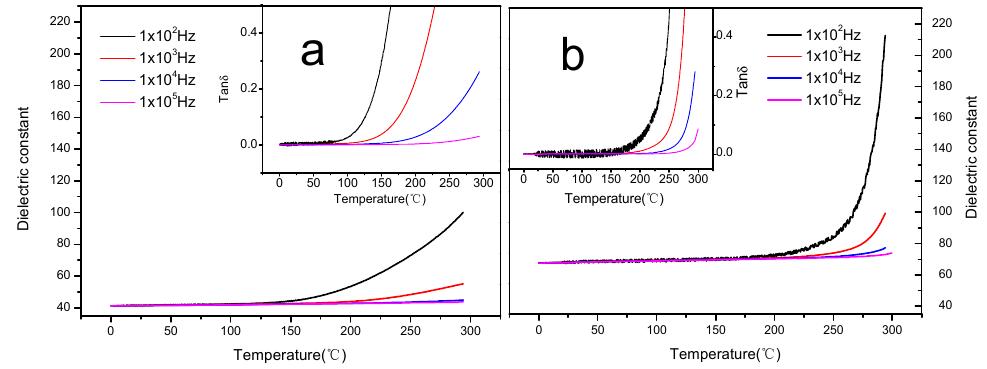
Figure 7. Temperature dependence of dielectric constant and tan δ at various frequencies from 10 2 Hz to 10 5 Hz. ( a ) for LTO single crystal and ( b ) for Ta-LTO single crystal.